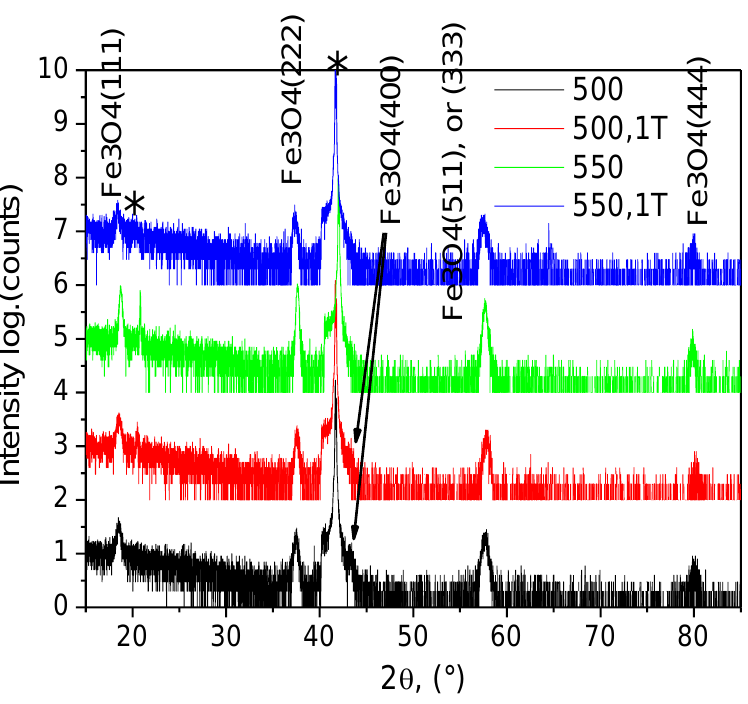
Figure 2. XRD patterns of the Fe 3 O 4 films grown on Al 2 O 3 sapphire in Ar+H 2 atmosphere (*-Al 2 O 3 substrate peaks).